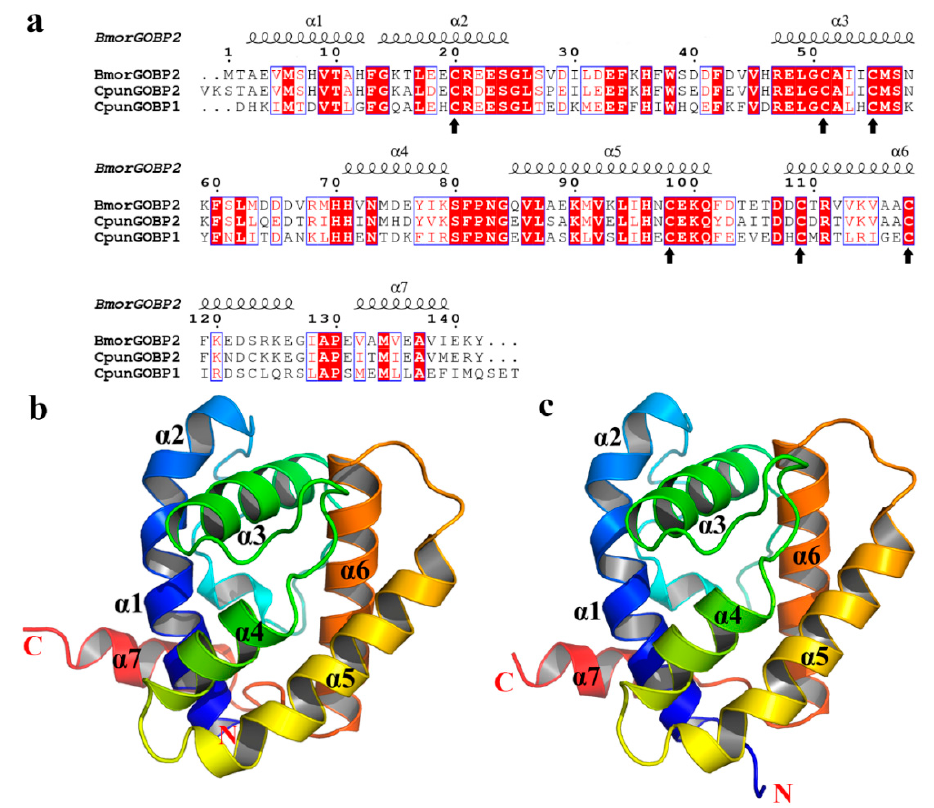
Figure 3. Three-dimensional models of CpunGOBP1 and CpunGOBP2: ( a ) Sequence alignment of BmorGOBP2, CpunGOBP1, and CpunGOBP2. Conserved residues are highlighted in white letters with a red background and upward arrow represents the conserved Cysteine residues in the GOBP1 and two sequences ( b ) and ( c ) were structural model of CpunGOBP1 and CpunGOBP2, respectively.